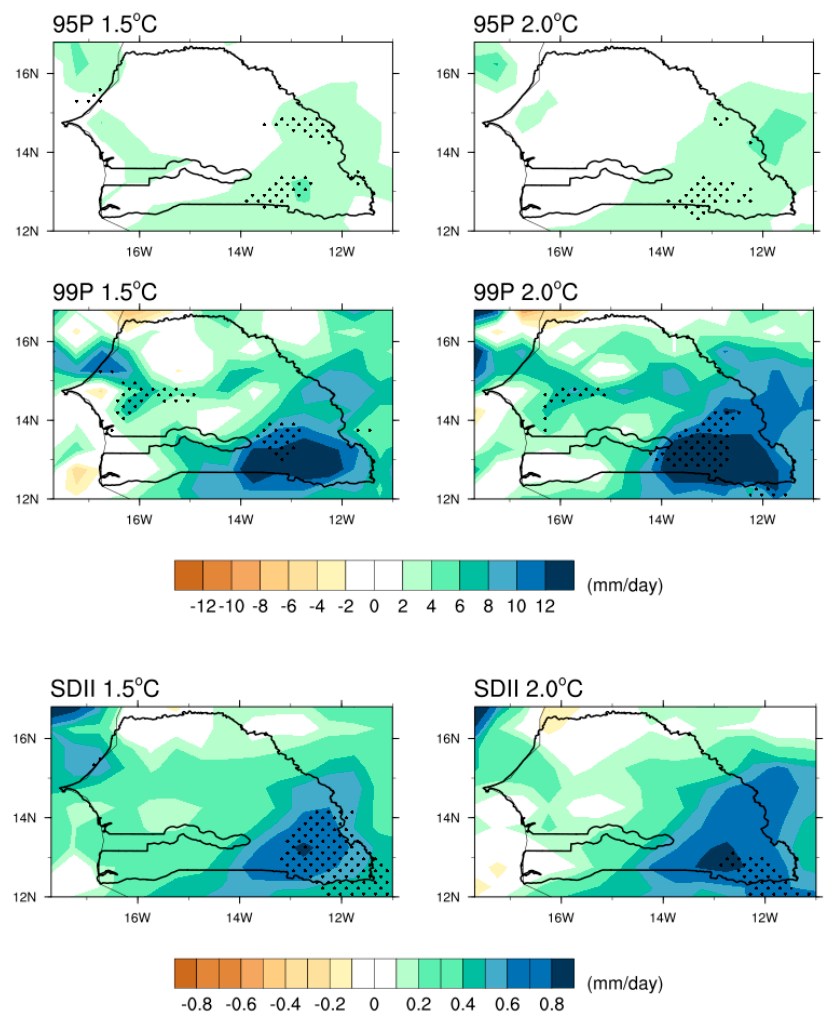
Figure 7. Seasonal (JAS) changes of very wet days (95P) ( first row ), extremely wet days (99P) ( second row ), and rainfall intensity index (SDII) ( third row) changes under 1.5 ◦ C ( left column ) and 2.0 ◦ C ( right column ) GWLs. Statistically significant changes (Student’s t -test) at 95% confidence level are represented by black dots.